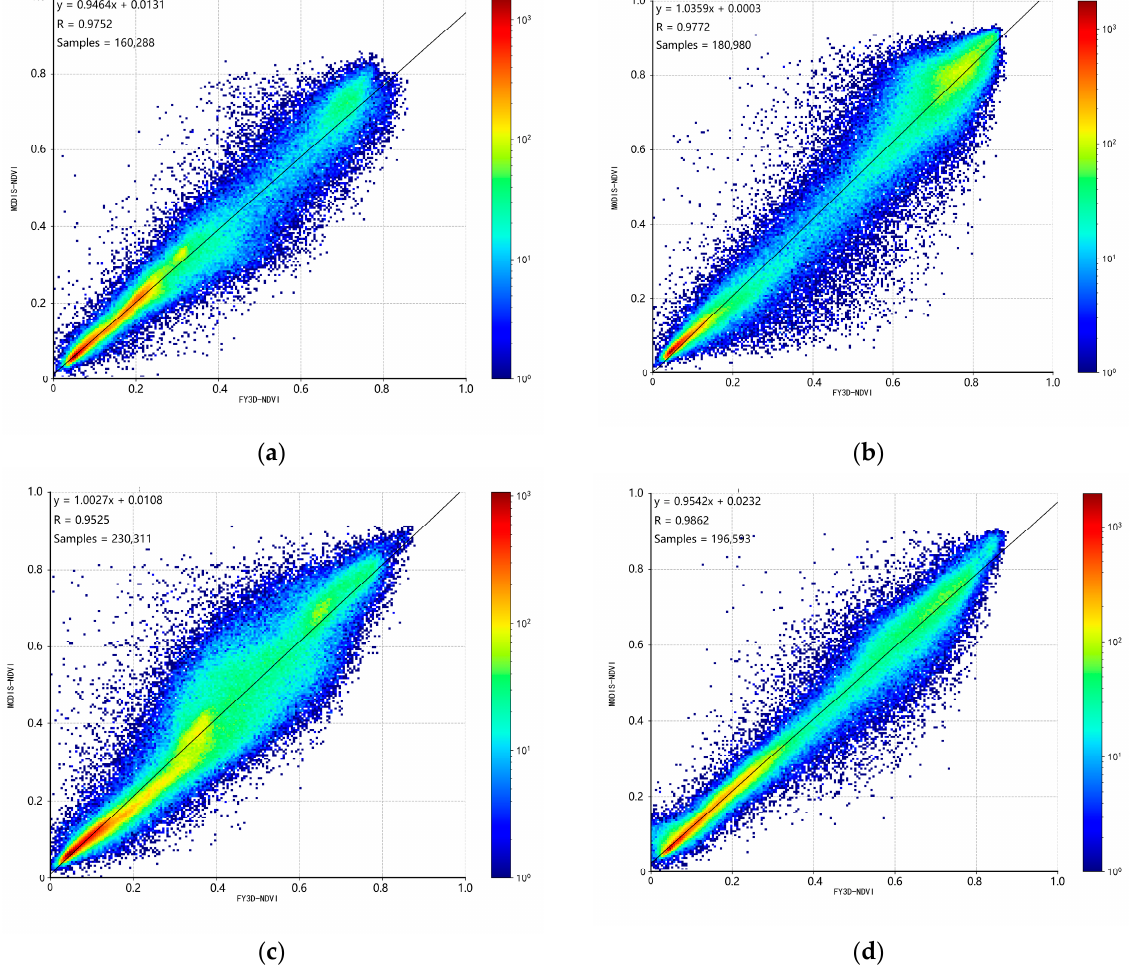
Figure 6. Density scatter plots of FNDVI versus MNDVI in different seasons, including ( a ) spring, ( b ) summer, ( c ) autumn, and ( d ) winter.